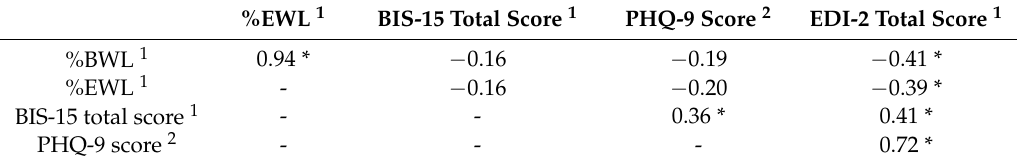
Table 2. Correlations among weight loss, impulsivity, depression, and pathological eating behavior.